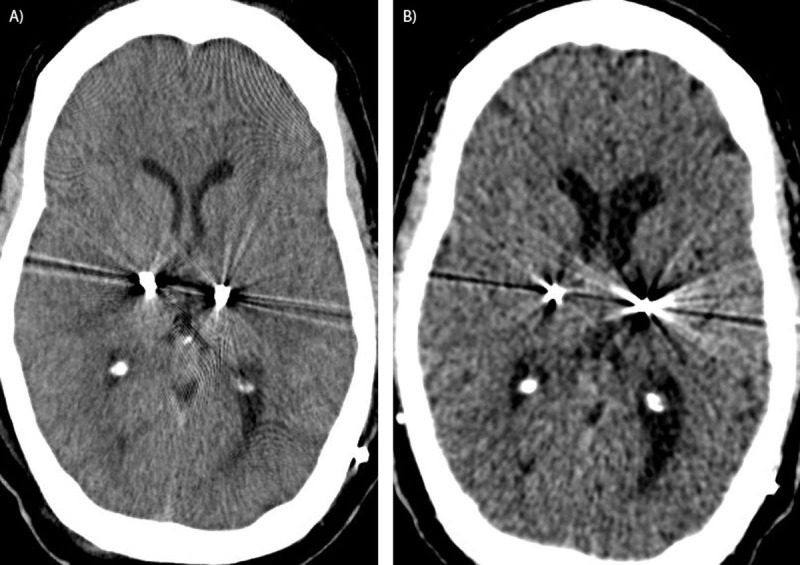
Changes in noncontrast head CT over time. Initial postoperative CT in 2014 (A) was normal, with bilateral VIM-DBS leads in place. Recent CT in 2019 (B) shows increased ventricular size and subtle left > right hemispheric atrophy.